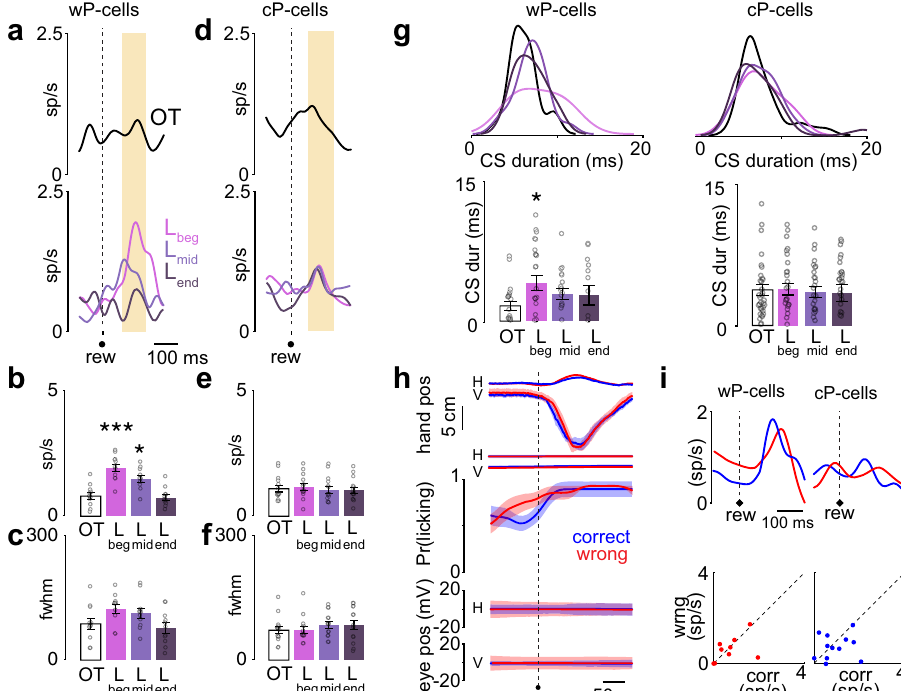
Fig. 3 Only wP-cells encoded learning-dependent signal after the animal ’ s decision. a Top panel: CS spike density functions in the reward epoch for wP- cells in the OT condition. Bottom panel: same for wP-cells in L beg , L mid , and L end . n = 11 wP-cells. b Peak fi ring rate of wP-cells in OT, L beg , L mid , and L end conditions in the reward epoch. *** P < 0.001, * P < 0.05, two-tailed Wilcoxon signed rank test. n = 11 wP-cells. c Temporal dispersion of CS activity for cP- cells (estimated as the full width at half maximum fi ring rate) in OT, L beg , L mid , and L end conditions in the reward epoch. n = 11 wP-cells. d Same as a but for cP-cells. n = 14 cP-cells. e Same as b but for cP-cells. n = 14 cP-cells. f Same as c but for cP-cells. n = 14 cP-cells. g Left: duration of CS waveforms in OT, L beg , L mid , and L end conditions for wP-cells (left, n = 11 wP-cells) and for cP-cells (right, n = 14 cP-cells). Histograms were normalized on the maximum frequency among all epochs. * P < 0.05, two-tailed Wilcoxon signed rank test. h From top to bottom: mean horizontal (H) and vertical (V) hand positions of the hand that was associated with the symbol presented, mean H and V hand positions of the hand that was not associated with the symbol presented, mean probability of licking, mean H and V eye positions for correct (blue) and wrong (red) trials. n = 25 sessions. i Top: CS activity during L beg for correct (blue) and wrong (red) trials for wP-cells (left) and cP-cells (right). Bottom: scatter plot of peak neural activity for correct and wrong trials for individual wP-cells (left) and cP-cells (right). Data shown as mean ± s.e.m. Source data are provided as a Source Data fi